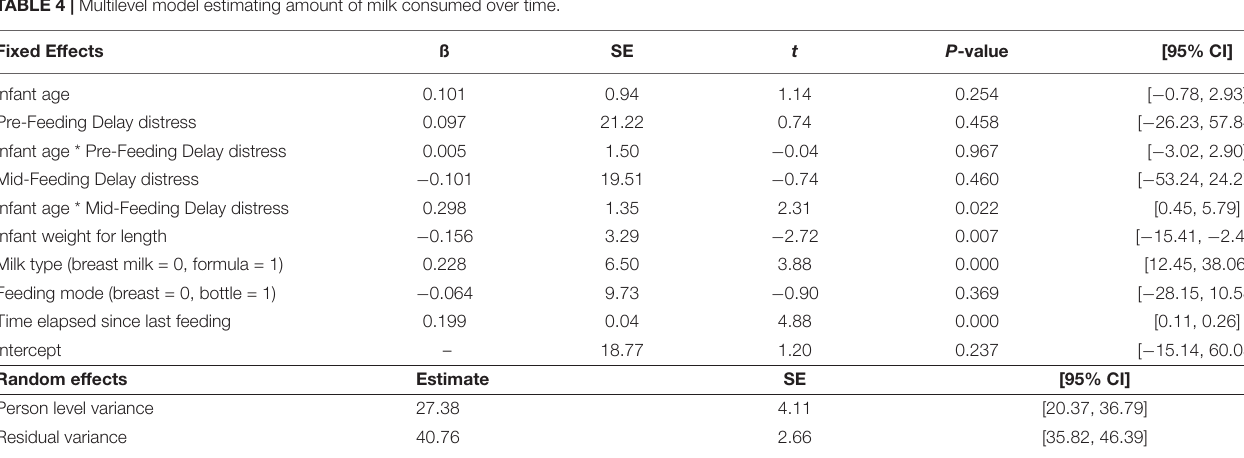
FIGURE 1 | Mean proportion of Pre-Feeding and Mid-Feeding Delay distress across development. The proportion of distress in each delay segment was calculated as the total number of intervals with distress present divided by the total number of coded intervals. TABLE 4 | Multilevel model estimating amount of milk consumed over